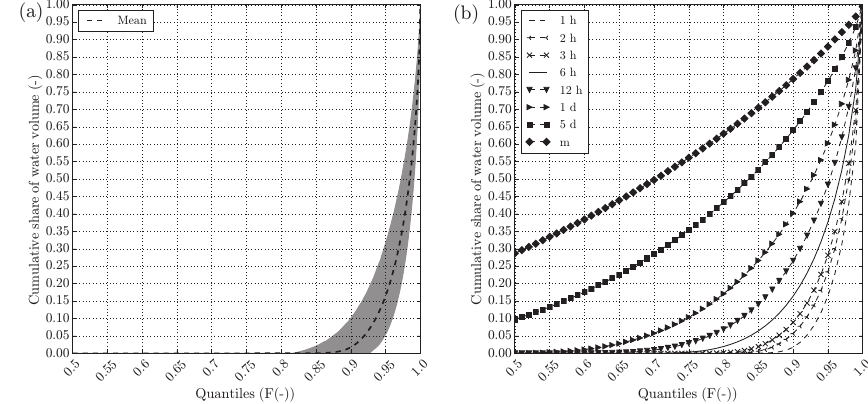
Figure 2. The (a) range of the Lorenz curves and the mean Lorenz curve for the hourly rainfall values of all the rainfall gauges inside the study region. The (b) mean Lorenz curves for different temporal resolutions.